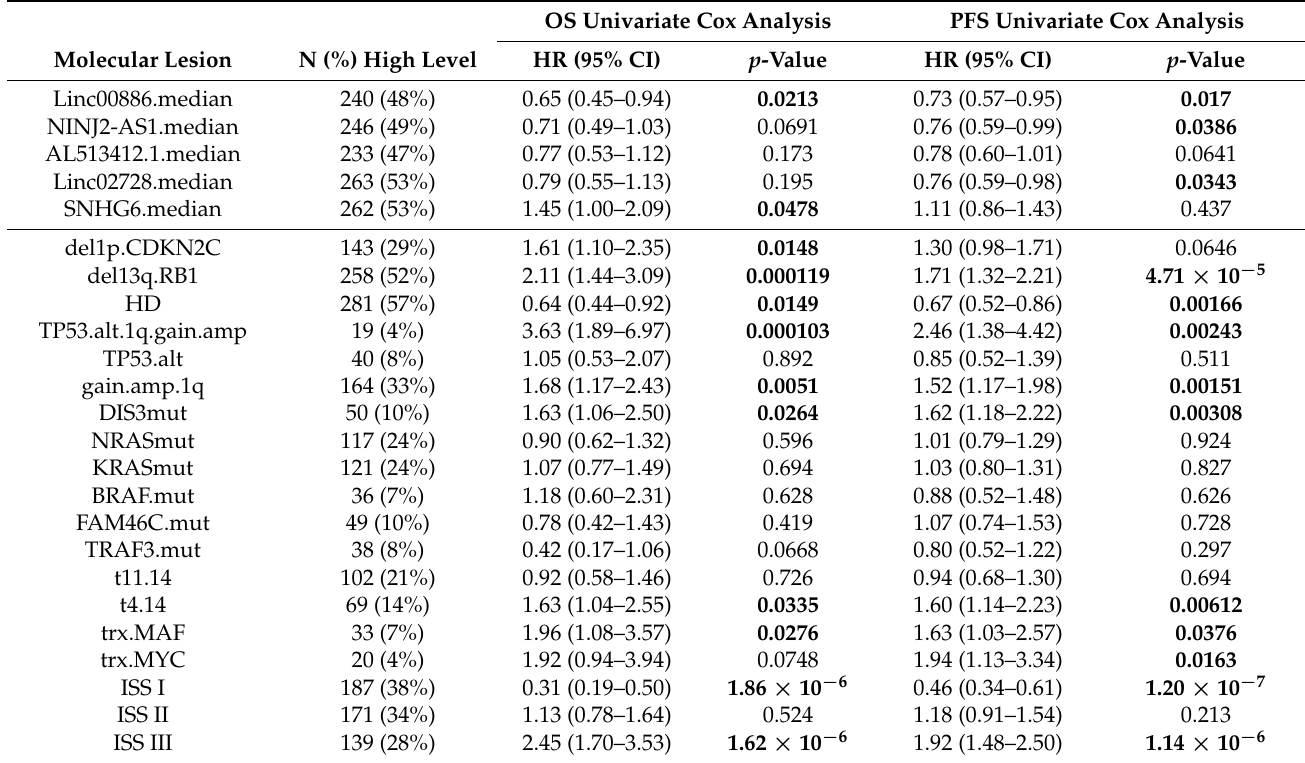
Table 3. Results of Cox regression univariate analysis for 5 lncRNAs with an unfavorable clinical outcome by Kaplan–Meier analysis. Higher expression level based on median cutoff in 497 MM dataset was tested in both OS and PFS. Significant p -values are marked in bold. Number (N) and fraction of MM patients at higher expression levels are indicated for each lncRNA. Clinical and molecular variables important for MM were also